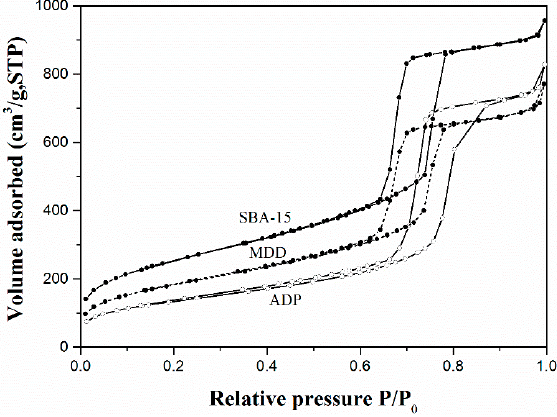
Figure 1. N 2 ‐ physisorption isotherms of SBA ‐ 15 and CuO/SBA ‐ 15 catalysts prepared by molecular designed dispersion (MDD) and ammonia ‐ driven deposition precipitation (ADP) methods. designed dispersion (MDD) and ammonia-driven deposition precipitation (ADP) methods. Table 1. Textual properties and copper loading of CuO/SBA ‐ 15 catalysts. Table 1. Textual properties and copper loading of CuO/SBA-15